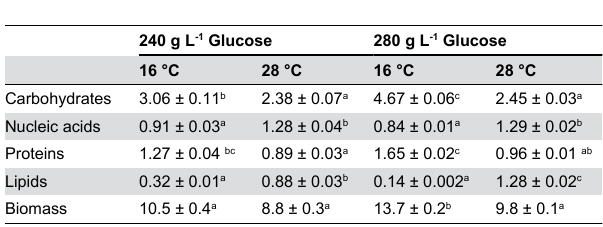
Table 3. Fluxes directed towards the synthesis of the main macromolecular components of the biomass expressed as C-mmol per 100 C-mmol glucose.